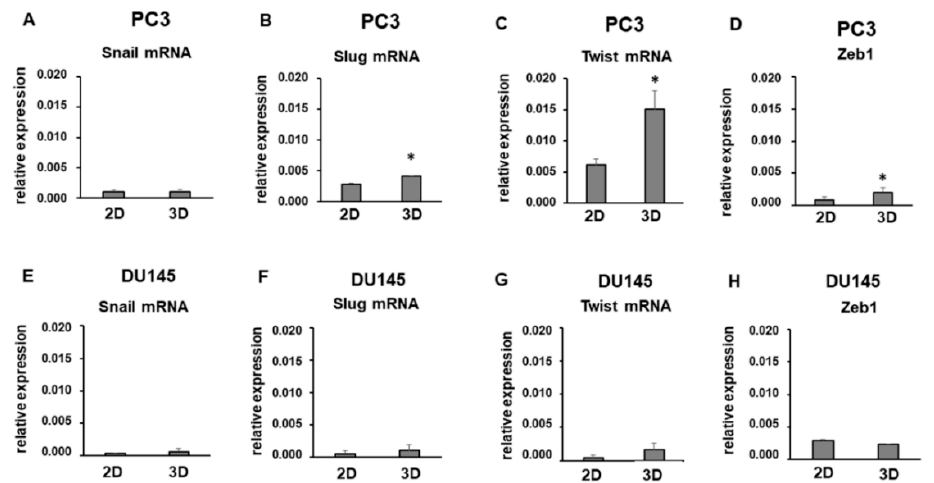
Figure 6. Snail, Slug, Twist and Zeb1 mRNA levels. Bar graphs showing Snail ( A ) and ( E ), Slug ( B ) and ( F ), Twist ( C ) and ( G ) and Zeb1 ( D ) and ( H ) mRNA levels in PC3 and DU145 cells grown in 2D-monolayers and 3D cell cultures. Data are means ± SD of duplicate samples. * p < 0.05 vs 2D-monolayer.